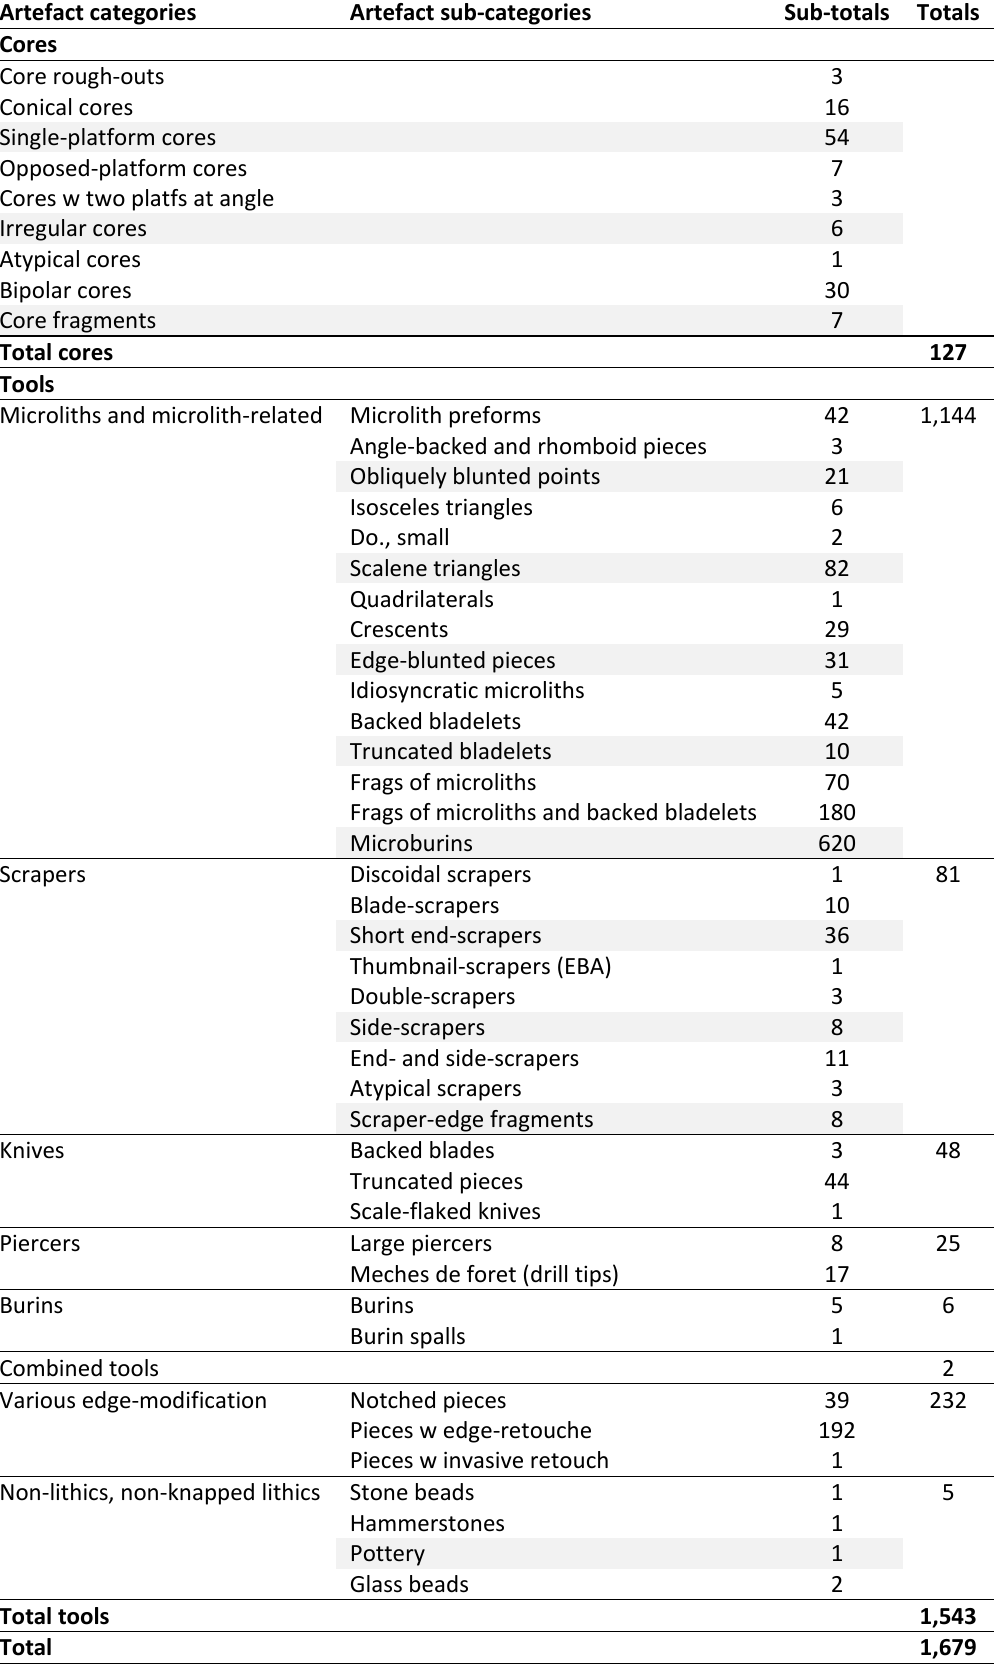
Table 2. The lithic cores and tools examined from Nethermills Farm (Kenworthy’s ‘specials’). Artefact categories Artefact sub-categories Sub-totals Totals Cores Core